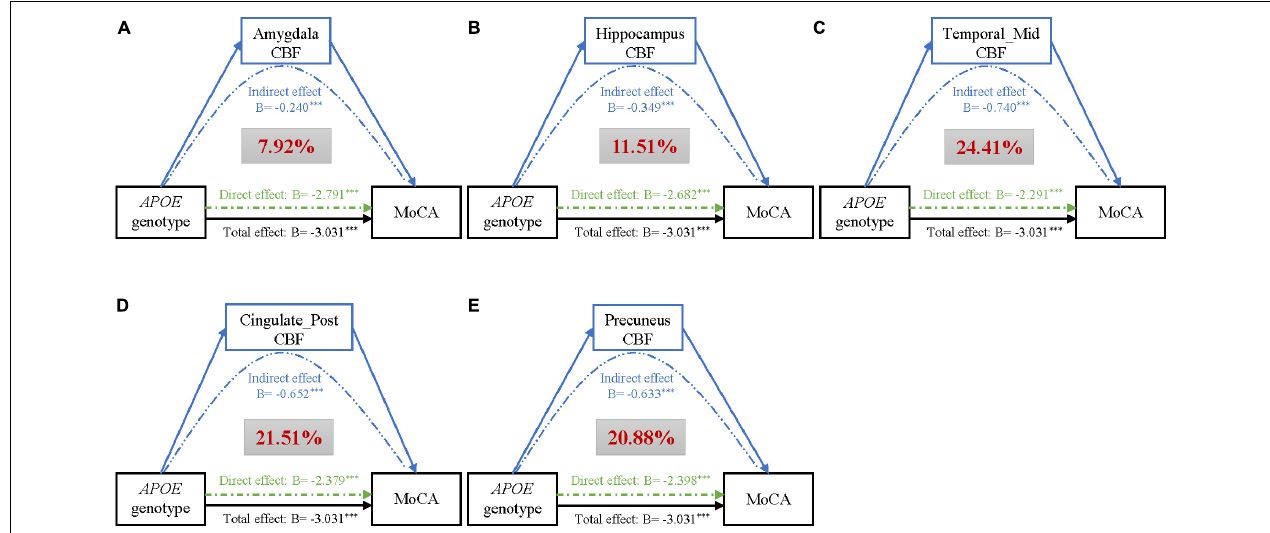
FIGURE 2 | Mediation analyses of CBF of different brain regions (A–E) on the association of APOE genotype with MoCA, adjusting for age, gender, and education. Black lines show the total effect of APOE genotype on MoCA, green lines show the direct effect (i.e., without mediation), and blue lines depict the CBF mediation effect. Path weights are presented in B -values (unstandardized coefficients), and the asterisks mean that the indirect/direct/total effect is significant. Significance was determined using bootstrapping with 5,000 iterations. Additionally, the red figure within the gray box represents the proportion of mediation. Abbreviations: CBF, cerebral blood flow; MoCA, Montreal Cognitive Assessment; ParaHippo, parahippocampal gyrus; Temporal_Mid, middletemporalgyrus; Cingulate_Post, posterior